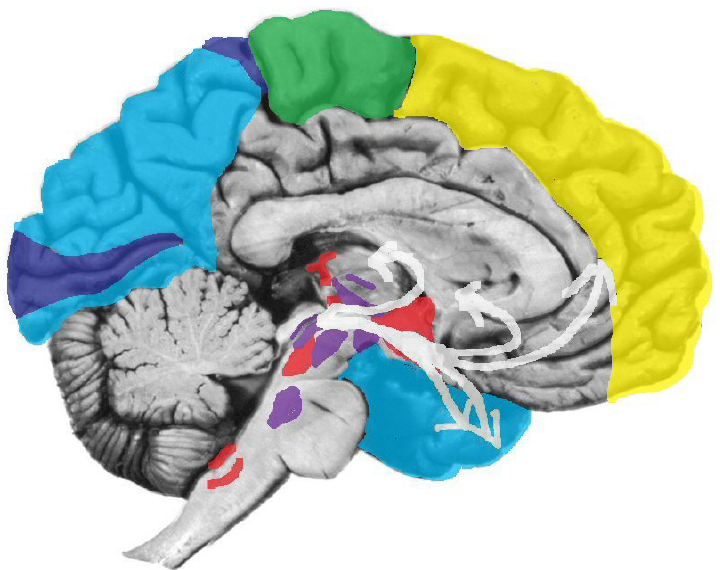
Figure 5. Red = some interoceptive nuclei; magenta = some ERTAS (arousal) nuclei; white = some basic emotion